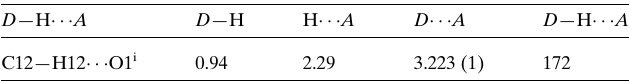
Table 2 Hydrogen-bond geometry (A˚ , (cid:3) ) for (II).